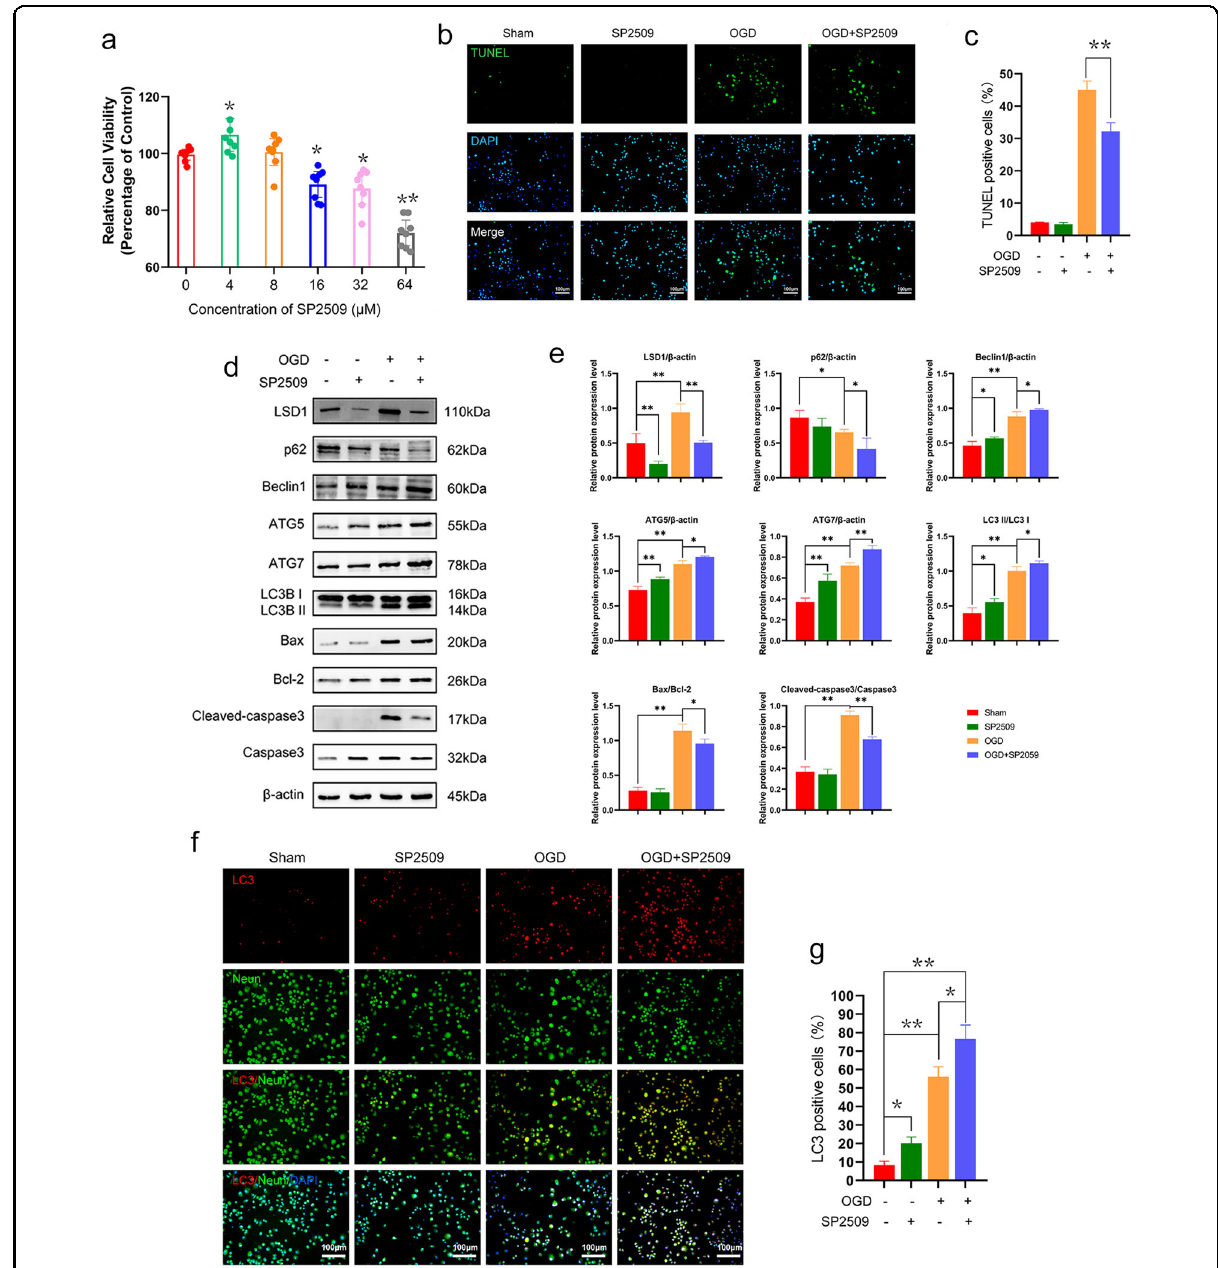
Fig. 3 In vitro simulation of PC12 cell damage due to SCI and the therapeutic effect of using SP2509 to pharmacologically inhibit LSD1. a CCK-8 ’ s measurement of a quantitative analysis of relative cell viability with various concentrations for treating nocodazole. n = 8. b PC12 cells apoptosis changes in each group were detected based on TUNEL staining. The SCI + SP2509 group had a lower proportion of TUNEL-positive neurons compared with the SCI group. Scale bar = 100 μ m. c Counting the TUNEL-positive neurons in the three experimental groups. d Western blot analysis of LSD1, autophagy, and apoptosis proteins following injury in different groups. e Semi-quantitative detection of autophagy and apoptosis protein levels. f Sample images of PC12 cells stained and a quantitative analysis including anti-LC3B and anti-NeuN antibodies in uninjured and injured rats with or without SP2509. DAPI (blue) was used to stain all cell nuclei. Scale bar = 1000 or 250 μ m. g Analysis of the amount of LC3 positive differentiated PC12 cells. One-way ANOVA and Tukey ’ s multiple comparisons test was used to compute p values for mean ± SD of three independent experiments. * p < 0.05; ** p <